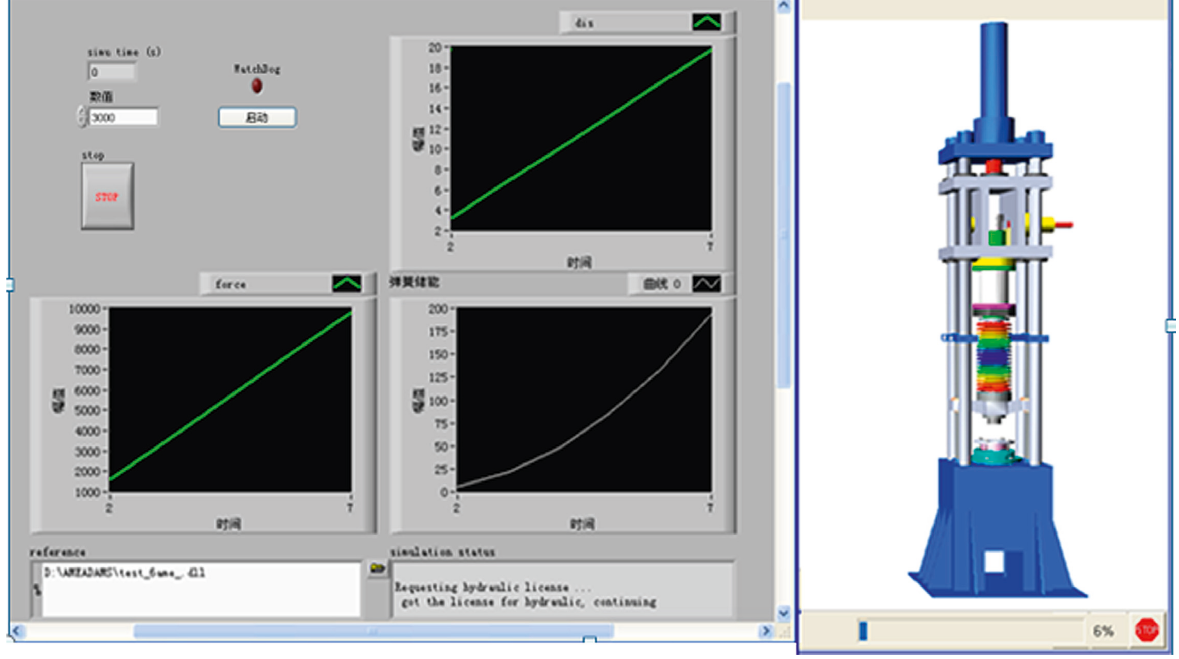
Figure 6: Control panel for cosimulation of energy